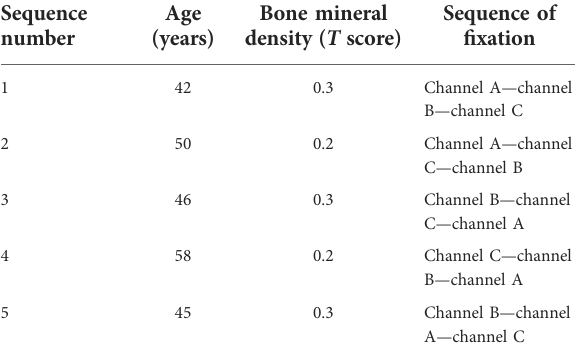
TABLE 1 General information on pelvic specimens and sequence of internal fi